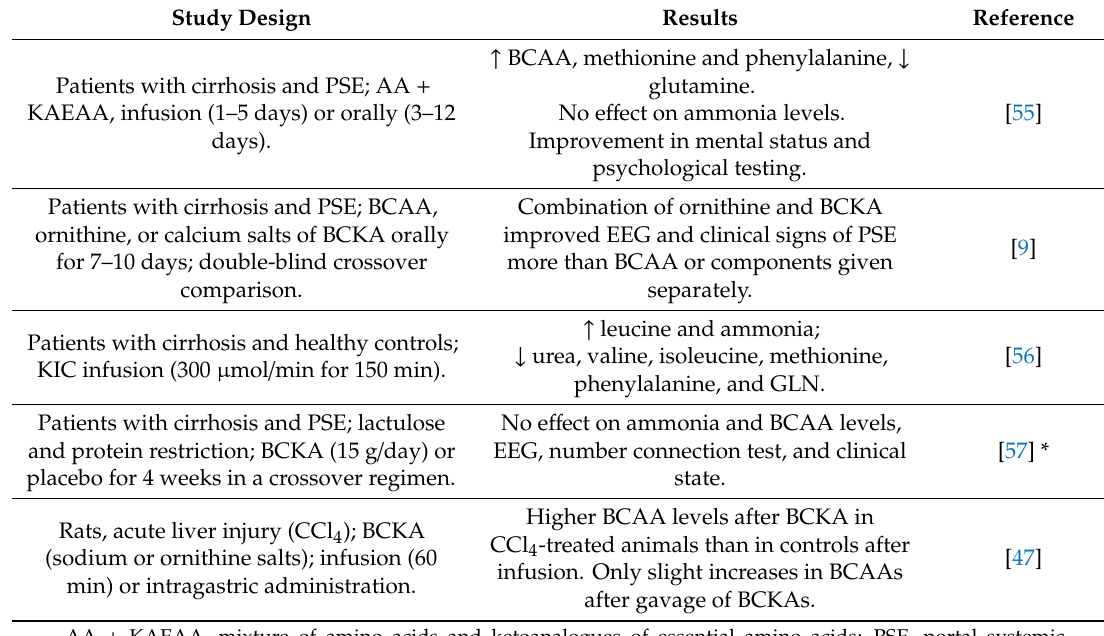
Table 1. E ff ects of BCKAs and ketoanalogues of essential amino acids (KAEAAs) in subjects with liver